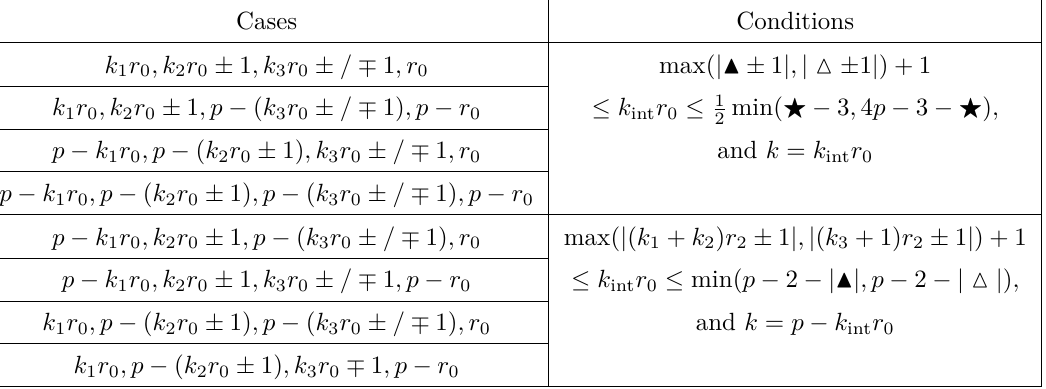
Table 14. The set of possible CBs in minimal models that a general dessin corresponds to. There are similar relations for s 0 by a simple substitution of the corresponding letters, where we have 0 , l, p (cid:1) set α = α and N = ( k ) r M = (1 − k ) r F = (cid:0) − | k + k 1 | + P k i r 0 . In 4 r 0 ,s 0 2 − k 1 0 , 3 0 , 1 2 − k 3 − i particular, k N ∗ is a necessary condition. i, int r 0 ∈